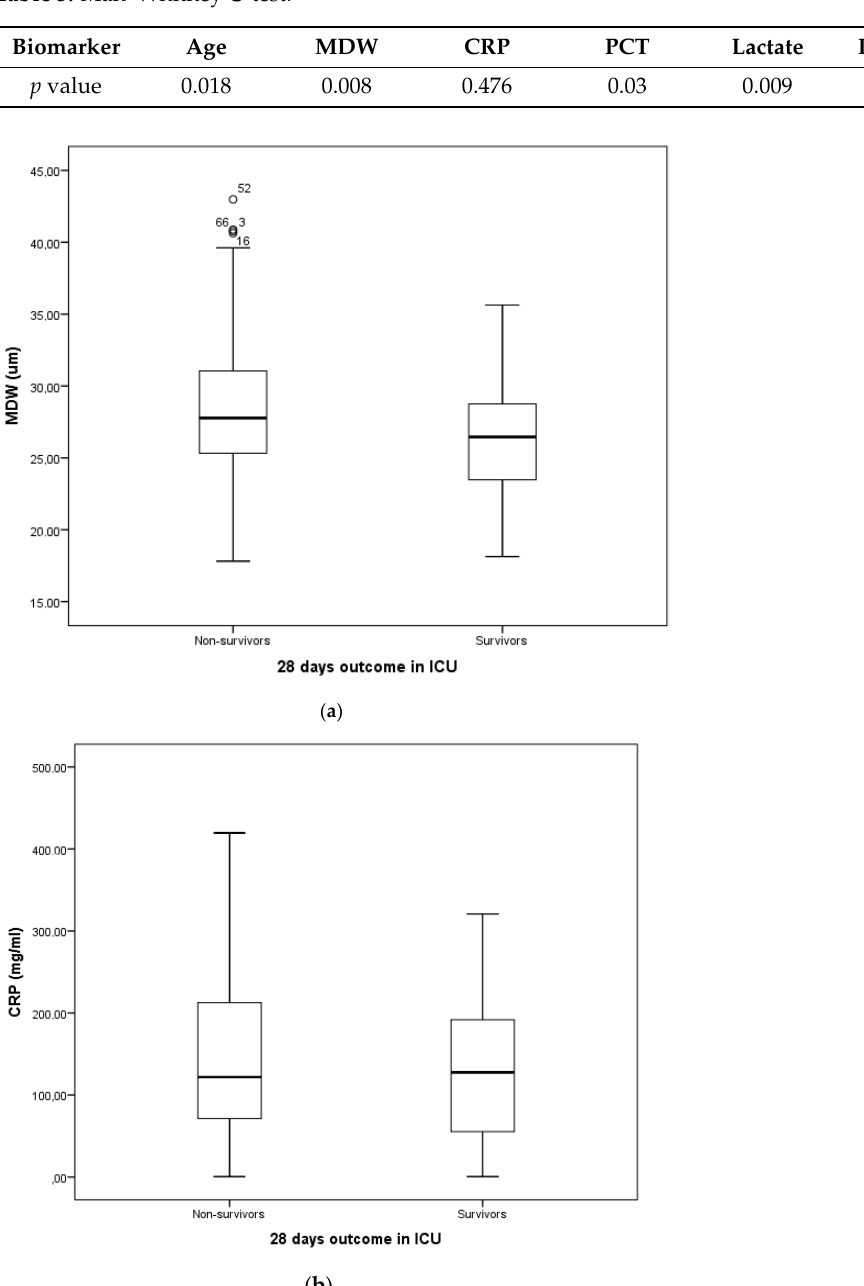
Figure 2. Box plots of ( a ) MDW (μm) and ( b ) CRP (mg/mL) in non-survivors and survivors group. Spearman’s correlation coefficient rho (Spearman rank correlation) is a non-paramet- ric test used to measure the strength of association between two variables. The value of a coefficient between 0.4–0.69 means a moderate correlation, but rho between 0.7 and 0.89 represents a strong correlation. There is a moderate correlation between MDW and PCT for p < 0.05 (rho), ICU days and lactate, age and ICU, MDW and CRP, PCT, and CRP (Table 4.). Comparison between survived and deceased in average age, SOFA score, require- ments for mechanical ventilation, and onset of shock in first 24 h is presented in Table 5. Receiver Operator Characteristic (ROC) curve analysis of MDW in predicting outcome showed AUC 0.627 (Figure 3). Table 4. Correlation between variables, * for p < 0.05; ** for p < 0.01. MDW